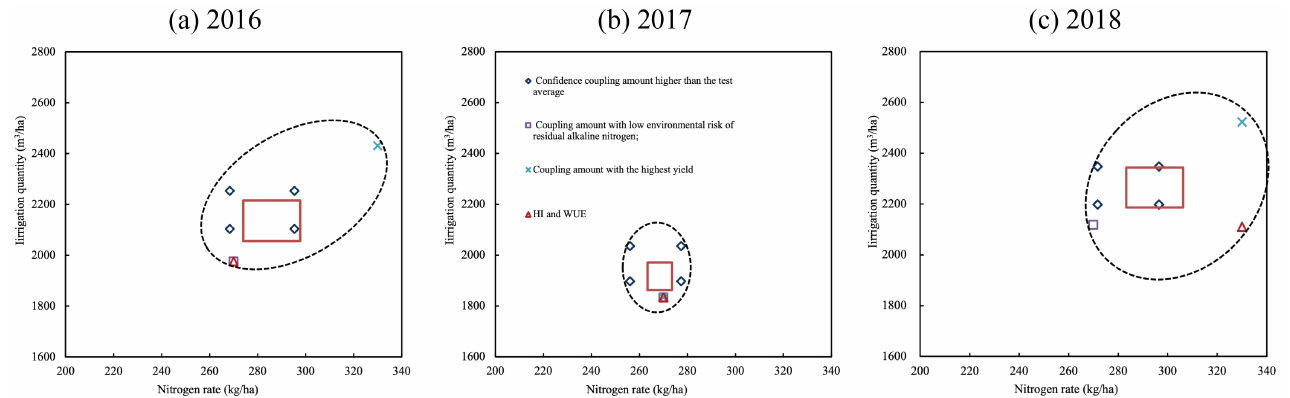
Figure 7. Graphic expression of water and nitrogen coupling area. ( a ) 2016. ( b ) 2017. ( c ) 2018. Note: rhombus represents confidence coupling amount higher than the test average; square represents coupling amount with low environmental risk of residual alkaline nitrogen; triangle represents harvest index; cross represents